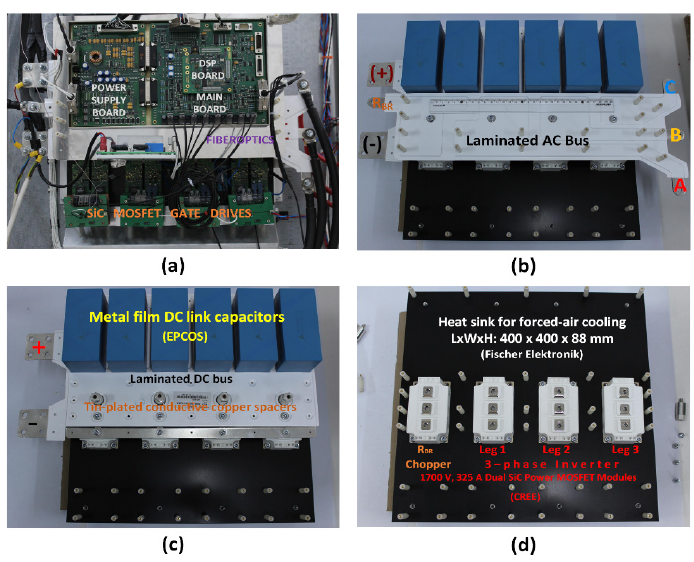
Figure 10. Power stage of traction converter. ( a ) Top layer, ( b ) third layer, ( c ) second layer, ( d ) bottom layer. SiC power MOSFETs have very fast turn-on and turn-off transitions, resulting in the generation of high di/dt and dv/dt at many points of the power circuitry. Since SiC power MOSFETs are switched on and off at much higher frequencies in comparison to those of Si-IGBTs, their utilization would be worsened i.e., an increase in the switching losses dur- ing turn-off, as well as in the voltage and current overshoots, and a ringing phenomenon would occur during turn-on and -off in cases where the parasitics were not minimized in the design phase. This is the main reason why special attention was paid to the design of the power stage and laminated busbars, as illustrated in Figures 9 and 10. Furthermore, the gate-drivers are positioned very close to gate–source terminals of the SiC power MOSFETs, as shown in Figures 9a,b and 10a in order to decrease the parasitics. The in- creased resistance of the gate-driver could be an alternative countermeasure at the ex- pense of slower turn-on and -off. In order to minimize the stray inductance of the current path between the high-fre- quency metalized film capacitors (blue colored) and SiC power MOSFETs, the laminated DC bus was designed with a minimum spacing between the (+) and ( − ) busbars by means of a high dielectric constant insulation material (Kapton). The high-frequency metalized film capacitors are uniformly distributed at the D1-S2 terminals of the SiC power MOSFET modules on the laminated busbar so as to supply the switching frequency currents with minimum inductance in the current paths. The stray capacitance from the SiC power MOSFETs to the heatsink and from the cables to the chassis was minimized to avoid the flow of high common-mode currents. 5. Experimental Results The performance of the all-SiC power MOSFET-based traction motor drive was tested on the full-scale physical simulator built in the Traction Systems R&D Laboratory for Railway Transportation. This full-scale simulator is on a per motor base and its details are described in [25]. This paper is accompanied by a video demonstrating the experi- mental work as the Supplementary Material.